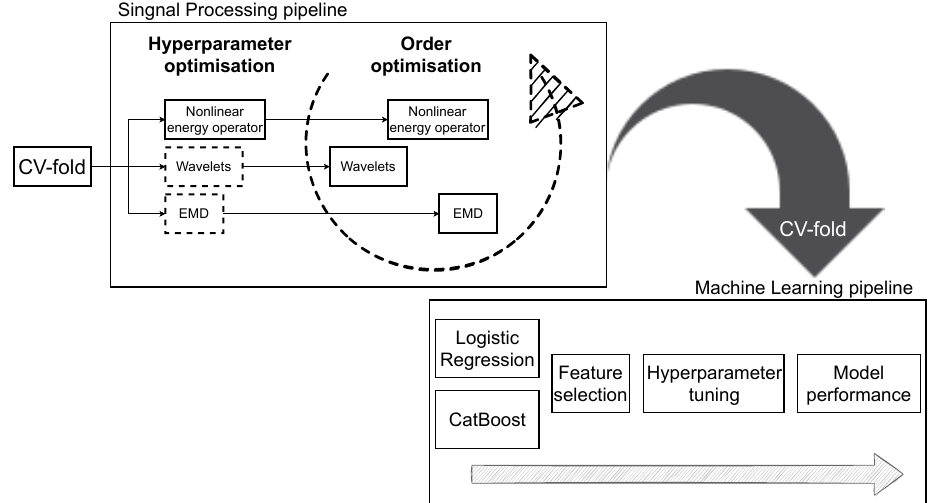
Figure 1. Diagram illustrating the optimisation steps of the signal processing and then machine learning (ML) pipelines. The dashed lines in the signal processing part represent elements optimised at the considered stage. The ML pipeline is run from left to right sequentially. After the optimal configuration for a signal processing pipeline is found, the dataset is processed and fed into the ML pipeline. At every step, the fixed set of features is extracted from the data and logistic regression is fitted and its goodness of fit is assessed (Akaike’s Information Criterion). The CV-fold corresponds to the cross-validation folds used throughout the